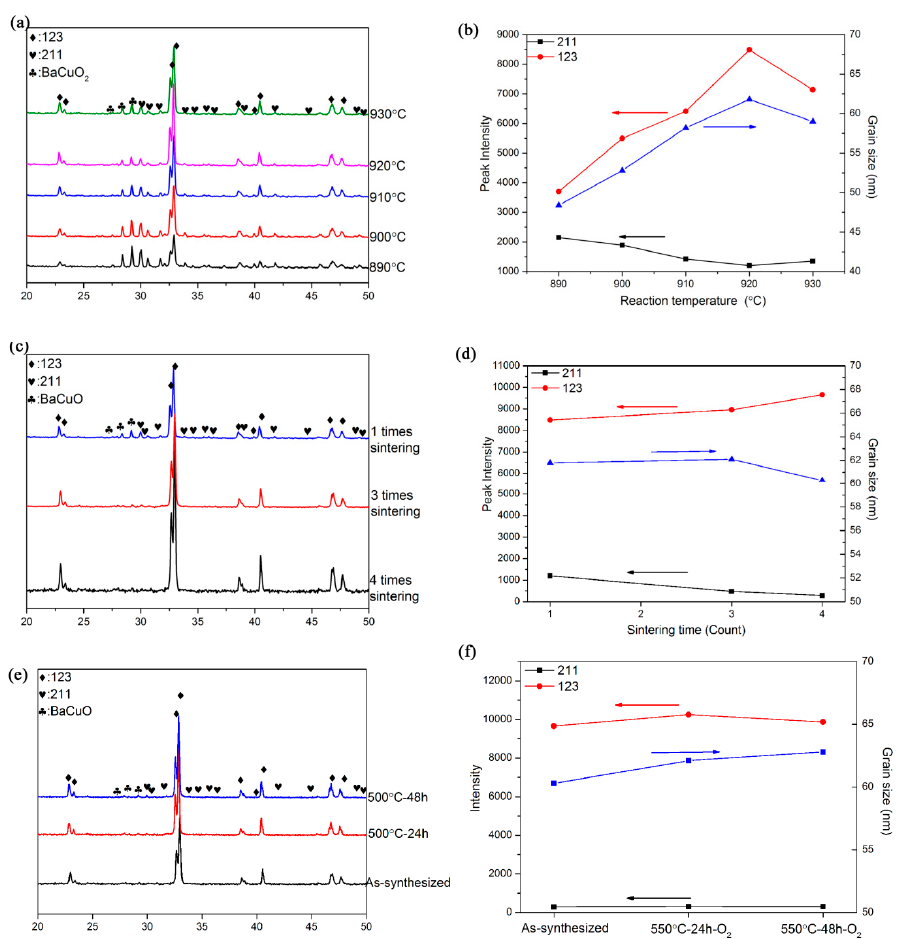
Figure 1. ( a ) phase formation of Er123 sintered by di ff erent temperature for 24 h; ( b ) Peak intensity and grain size from the XRD results of Er123 sintered by di ff erent temperature for 24 h; ( c ) phase formation of Er123 sintered at 920 ◦ C for 24 h by multiple times; ( d ) Peak intensity and grain size from the XRD results of Er123 sintered at 920 ◦ C for 24 by multiple times; ( e ) phase formation of Er123 with oxygen annealing at 500 ◦ C for 24~48 h; ( f ) Peak intensity and grain size from the XRD results of Er123 with oxygen annealing at 500 ◦ C for 24~48